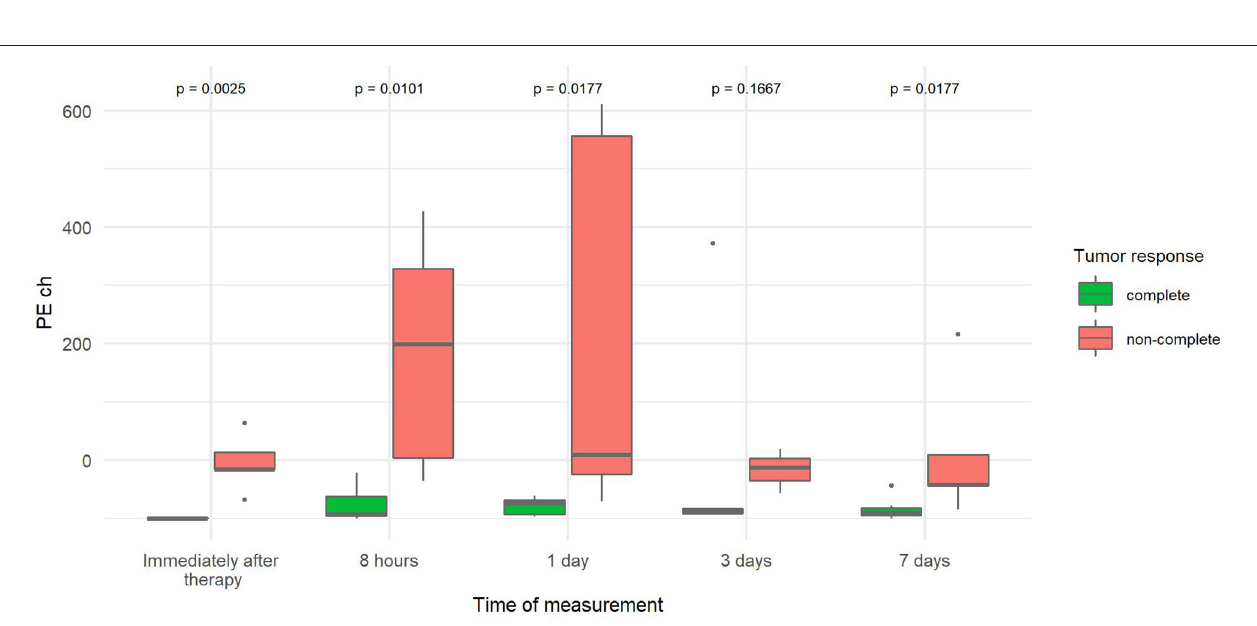
FIGURE 6 | Comparison of the percentage change in peak enhancement of tumor (PE ch) at different time points between canine tumors with a complete and non-complete response to electrochemotherapy (ECT) with gene electrotransfer of plasmid DNA encoding interleukin IL-12 (GET pIL-12). Note the p -values presented at the top of the image. PE ch is significantly lower for complete response tumors compared with non-complete response tumors immediately after therapy and at 8h and 7 days.